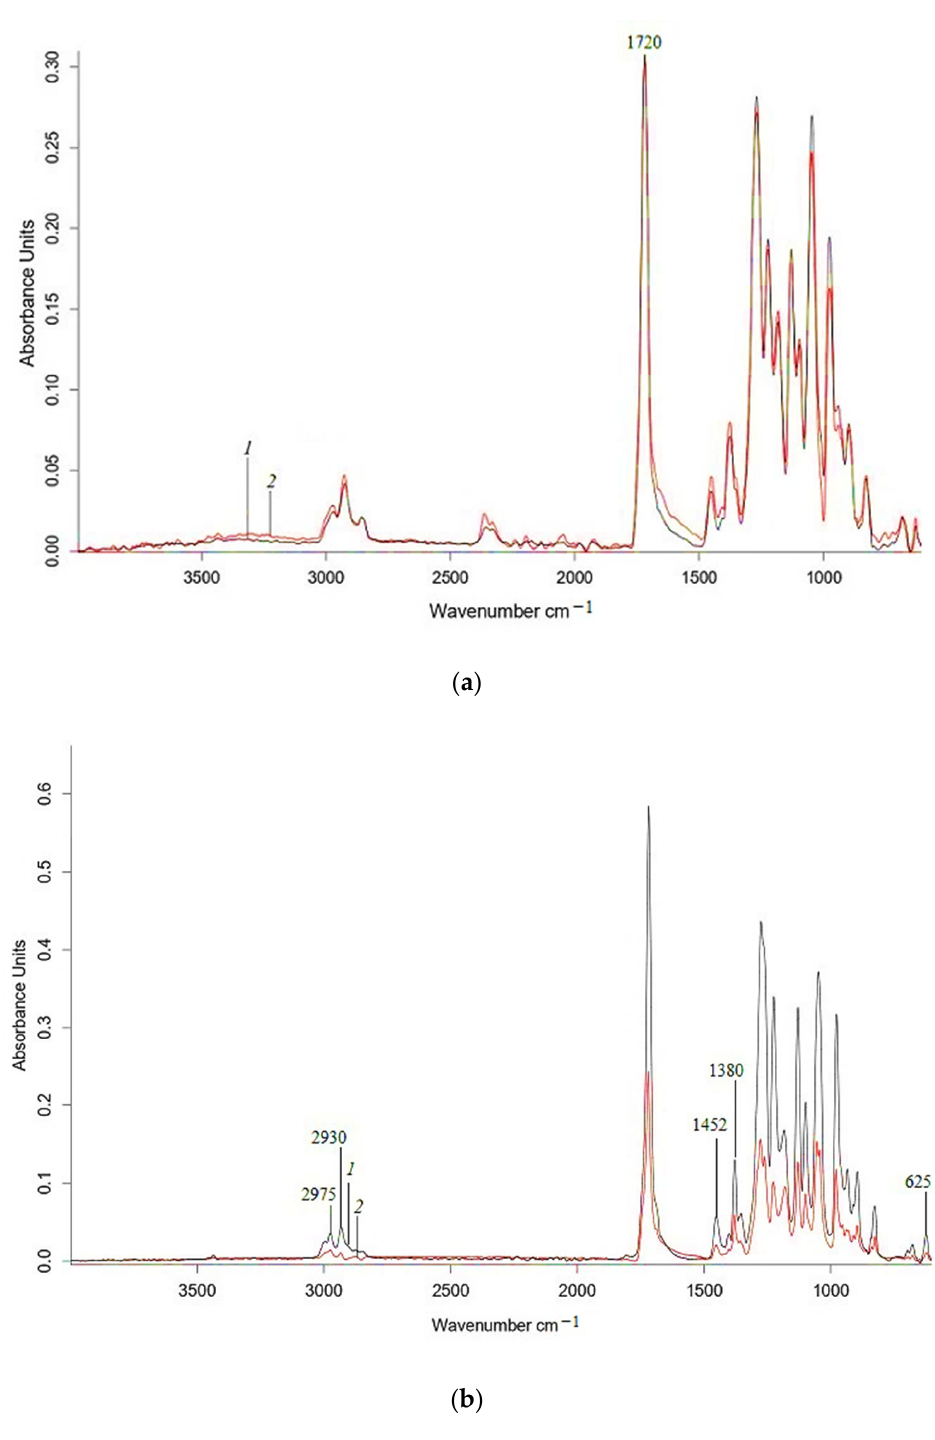
Figure 7. ATR-IR spectra of PHB ( a ) and 85PHB/15NBR ( b ) nonwoven fabrics (1) and 60 days after water (2).